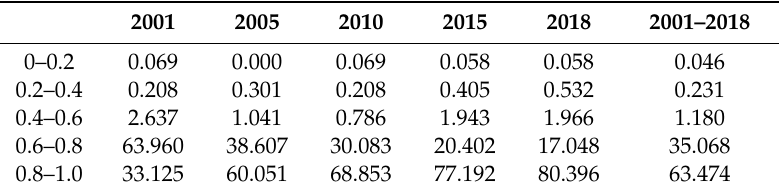
Table 3. Area ratio of different NDVI levels (%).